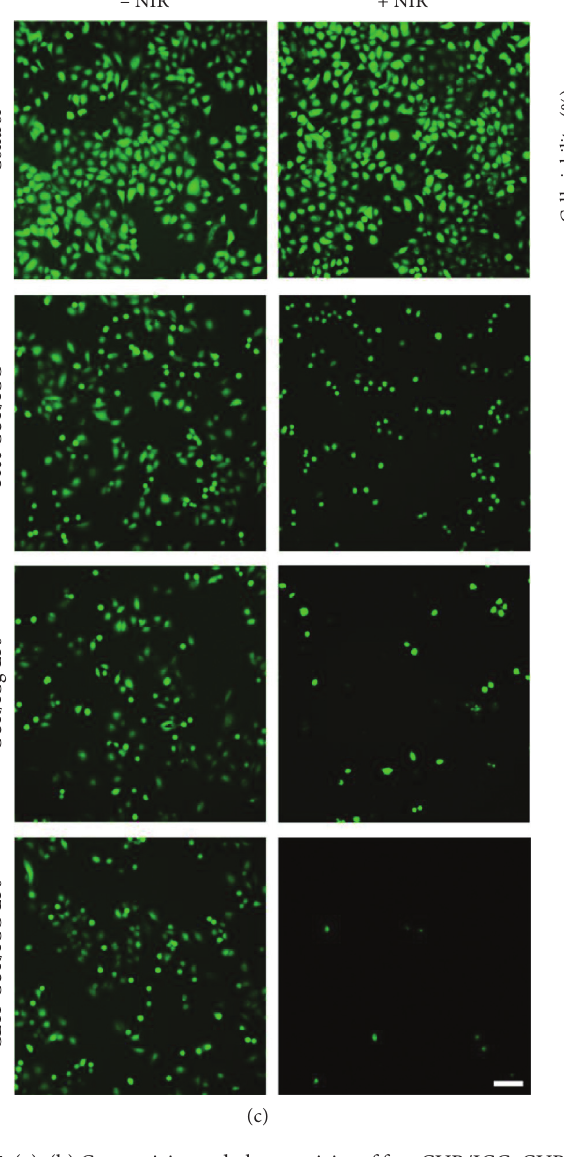
Figure 5: (a), (b) Cytotoxicity and phototoxicity of free CUR/ICG, CUR/ICG-LPs and GE11-CUR/ICG-LPs under the NIR laser irradiation (808 nm) of 1W · cm − 2 for 5 min at different concentrations on A549 cells after 24h incubation. (c) Fluorescence images of A549 cells stained with calcein-AM (green) after different treatments. Scale bar � 100 μ m. (d) Synergistic effect of photo- and chemotherapy based on GE11- CUR/ICG-LPs. Cytotoxicity of GE11-ICG-LPs, GE11-CUR-LPs, and GE11-CUR/ICG-LPs with or without laser exposure was performed by MTT assays. Data are expressed as mean ± SD ( n � 3). ∗ P < 0 . 05, ∗∗ P < 0 . 01 and ∗∗∗ P < 0 .